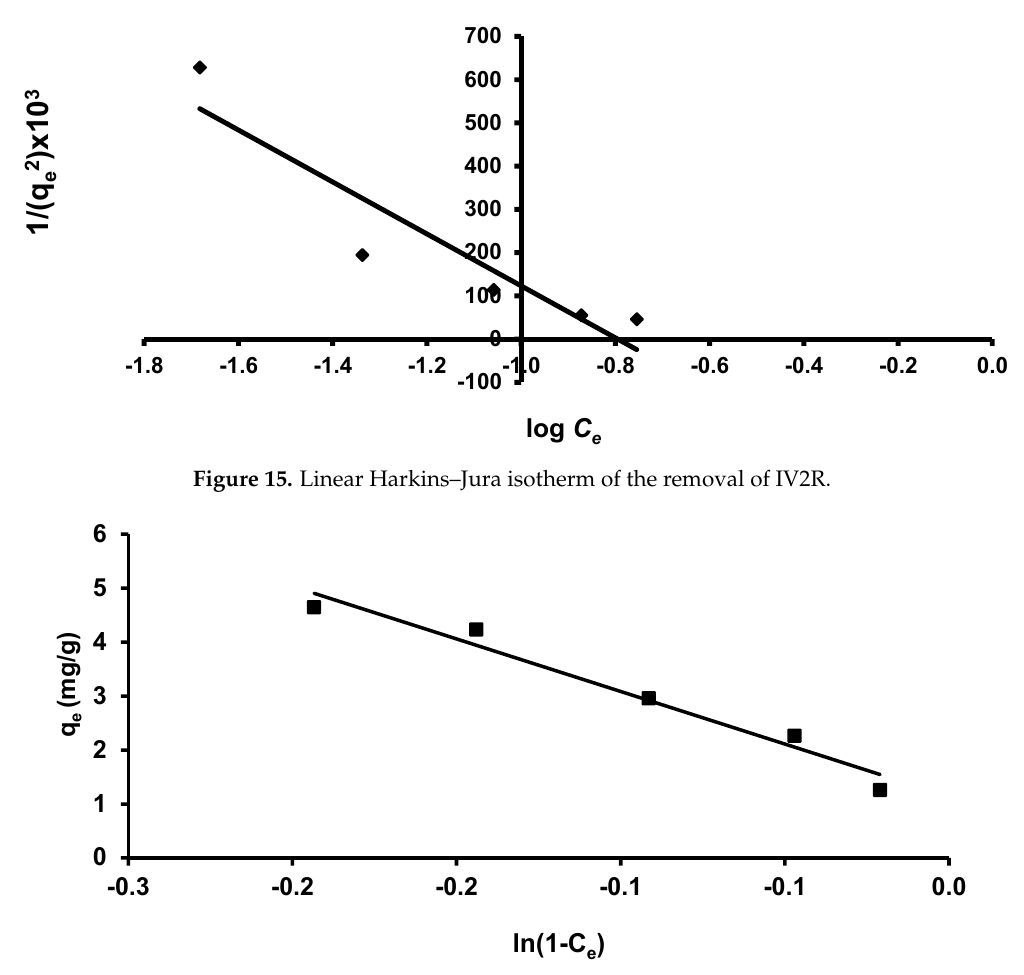
Figure 14. Linear Henderson isotherm of the removal of IV2R.